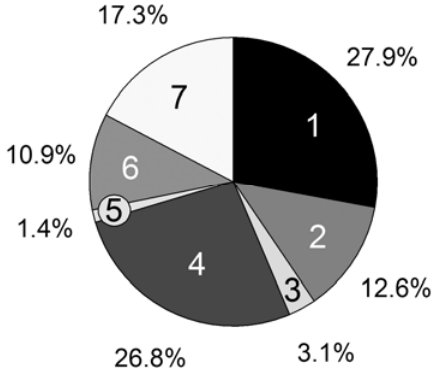
= 0.02 mol/L, Reaction Time = 1 0